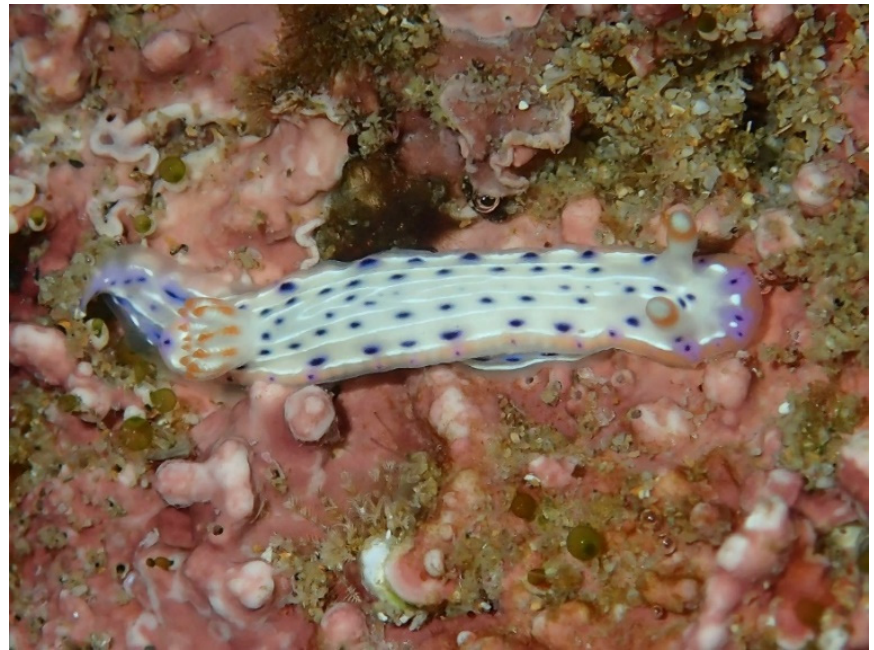
Figure 3. Hypselodoris bertschi , Woolgoolga Headland, NSW, 22 January 2022. The only observation of this species in Australia. Photo: S. D. A. Smith.